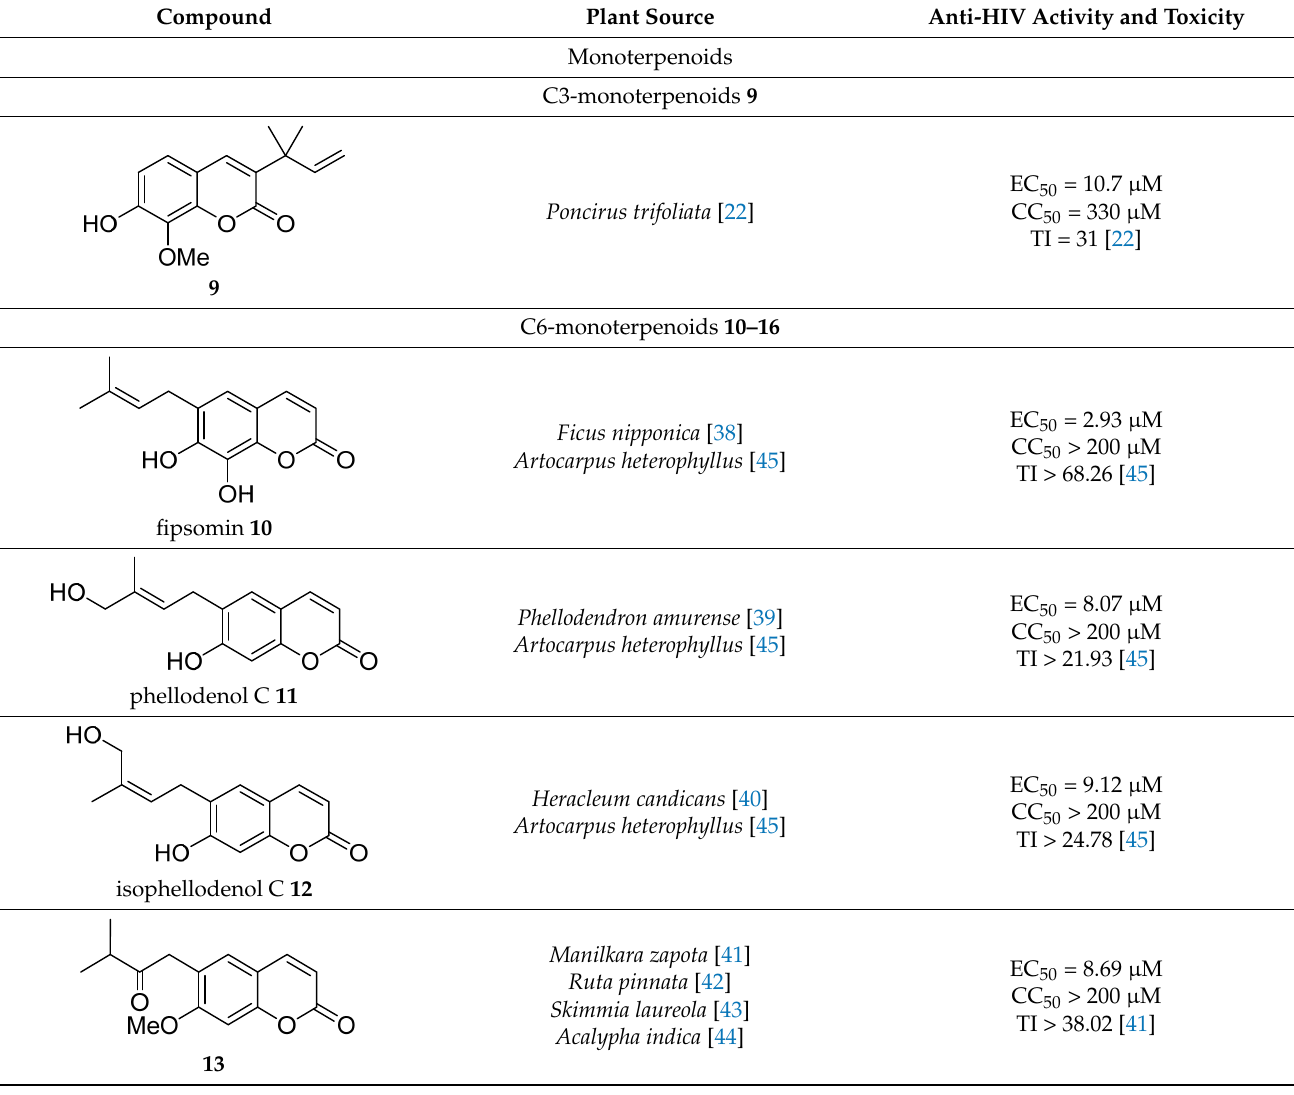
Table 2. C-terpenoid anti-HIV coumarins.